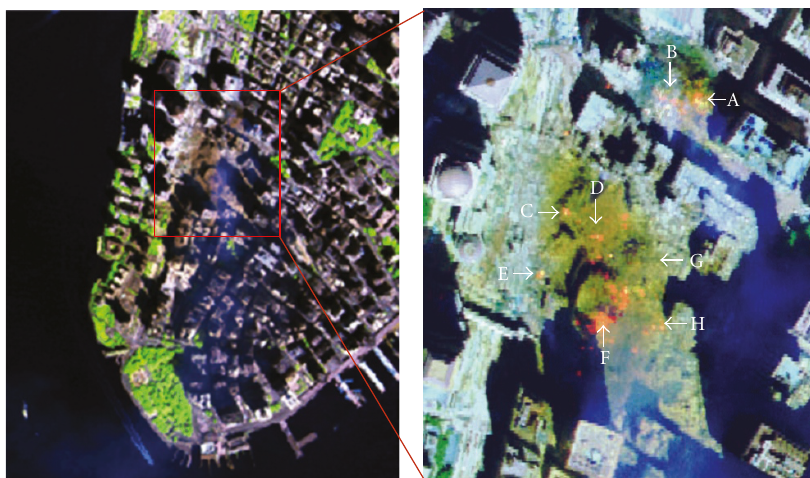
Figure 12: False color composition of an AVIRIS hyperspectral image collected by NASA’s Jet Propulsion Laboratory over lower Manhattan on September 16, 2001 (left). Location of thermal hot spots in the fires observed in World Trade Center area, available online: http://pubs.usgs.gov/of/2001/ofr-01-0429/hotspot.key.tgif.gif (right).